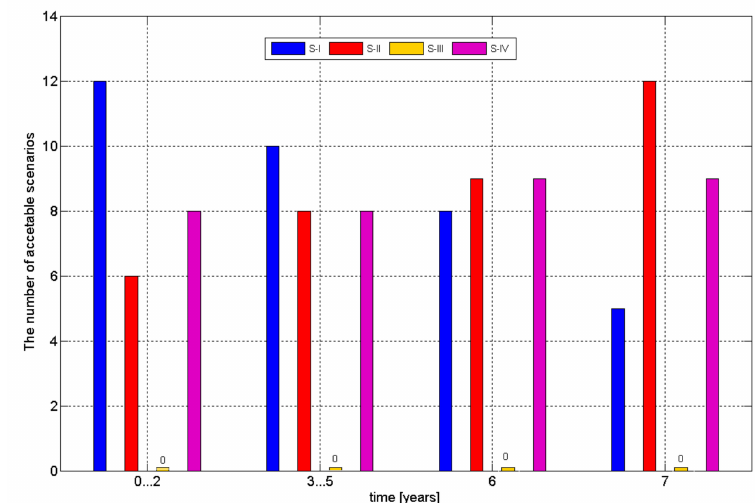
Figure 12. Results of the multi-criteria analysis of load distribution taking into account a decrease in the performance of the photovoltaic installation, fuel cell, and